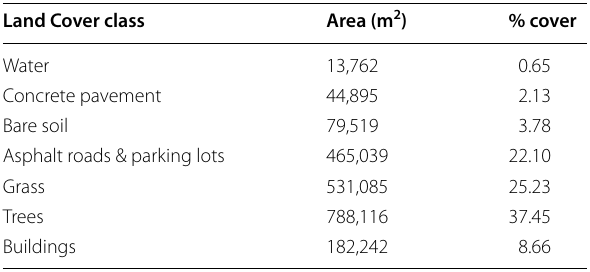
Source: The cover estimates are based on mapped land cover types based on Google Earth ® image (January